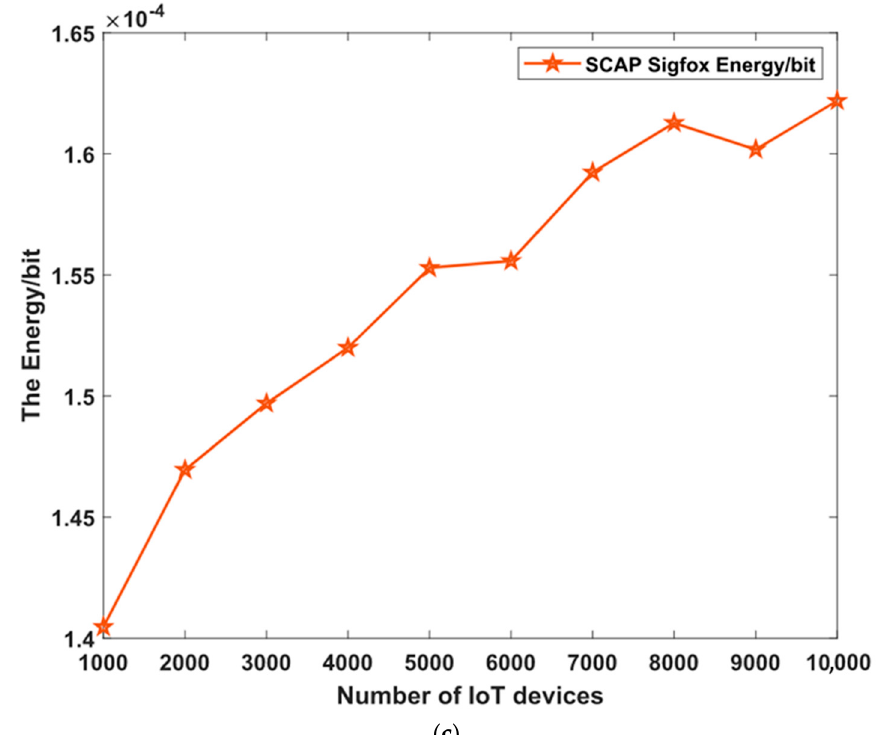
Figure 11. ( a ) The energy/bit value of original SigFox vs. SCAP SigFox; ( b ) the energy/bit value of original SigFox; and ( c ) the energy/bit value of SCAP SigFox.